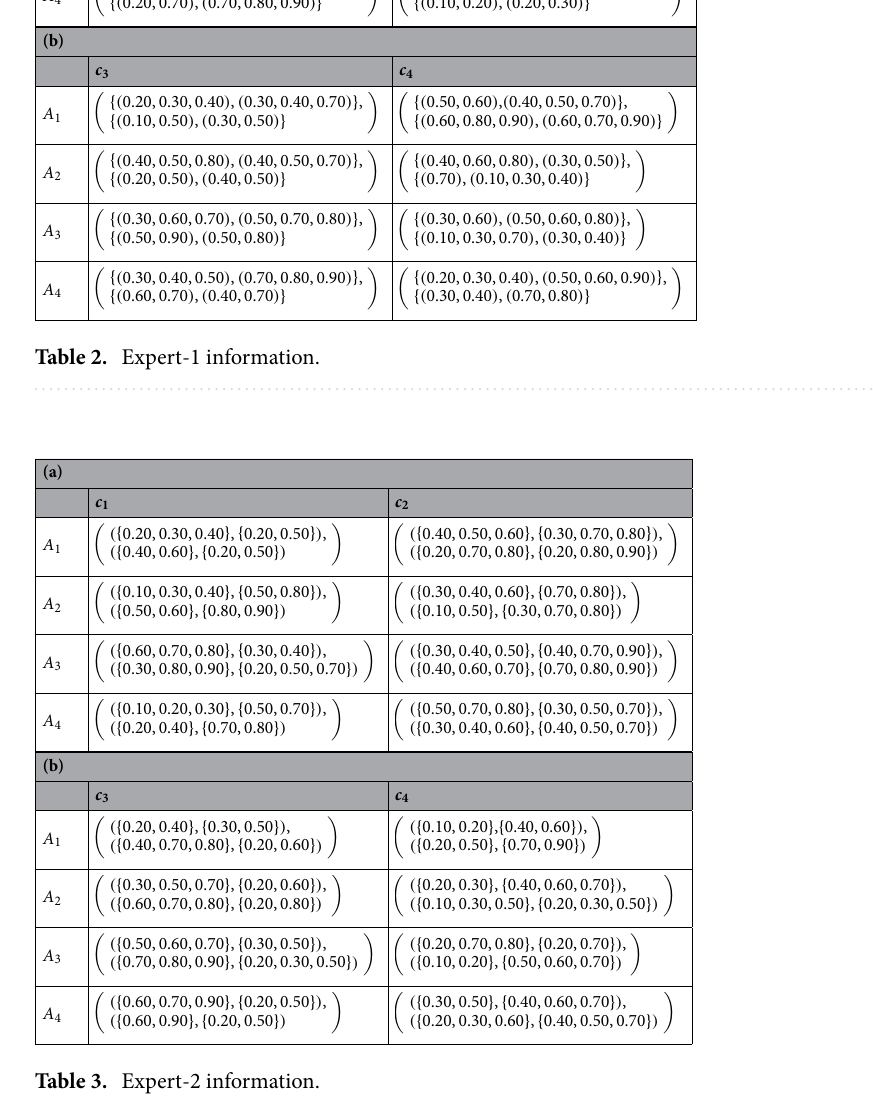
Table 3. Expert-2